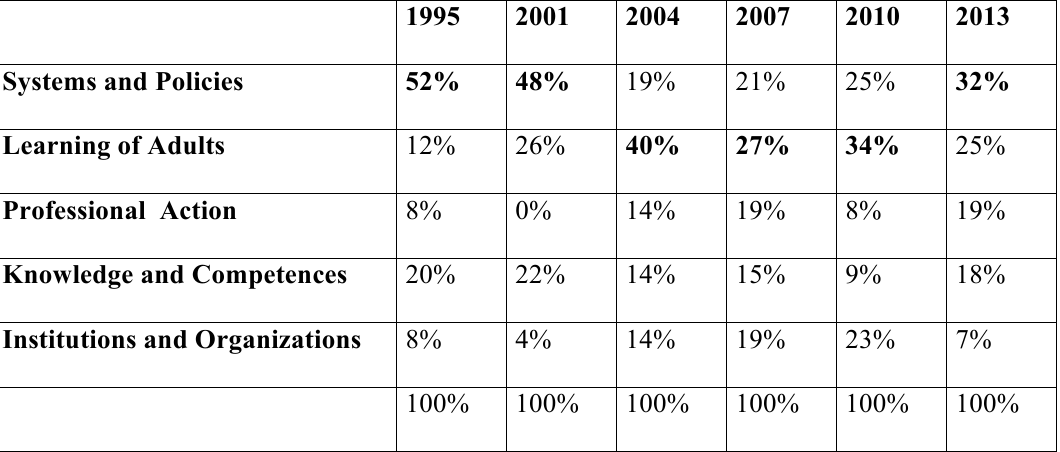
Table 5: ESREA conferences and the subject of research in papers 1995 2001 2004 2007 2010 2013 Systems and Policies 52% 48% 19% 21% 25% 32% Learning of Adults 12% 26% 40% 27% 34% 25% Professional Action 8% 0% 14% 19% 8% 19% Knowledge and Competences 20% 22% 14% 15% 9% 18% Institutions and Organizations 8% 4% 100% 100%